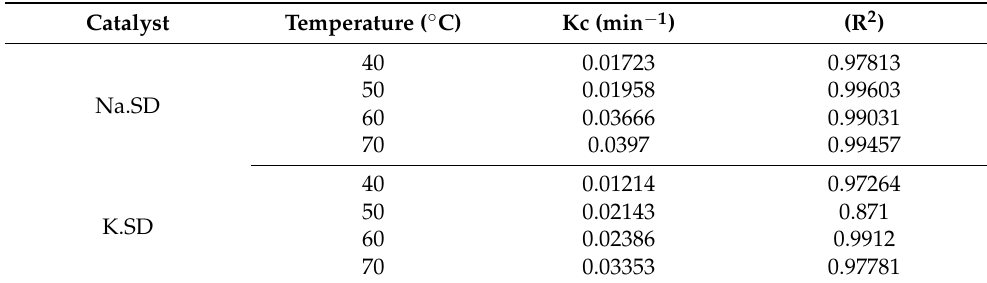
Table 3. The estimated values of the determination coefficient and rate constant of the pseudo-first- order kinetic